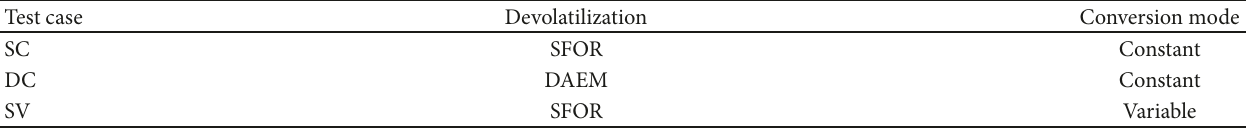
Table 3: Numerical test case setup list.